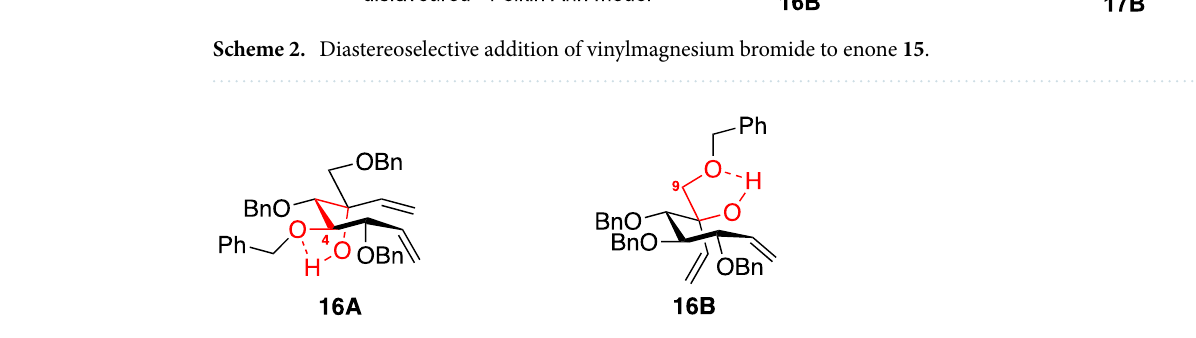
Figure 3. Intramolecular H-bonding interactions of the diastereomers 16A , 27A , 16B and 27B